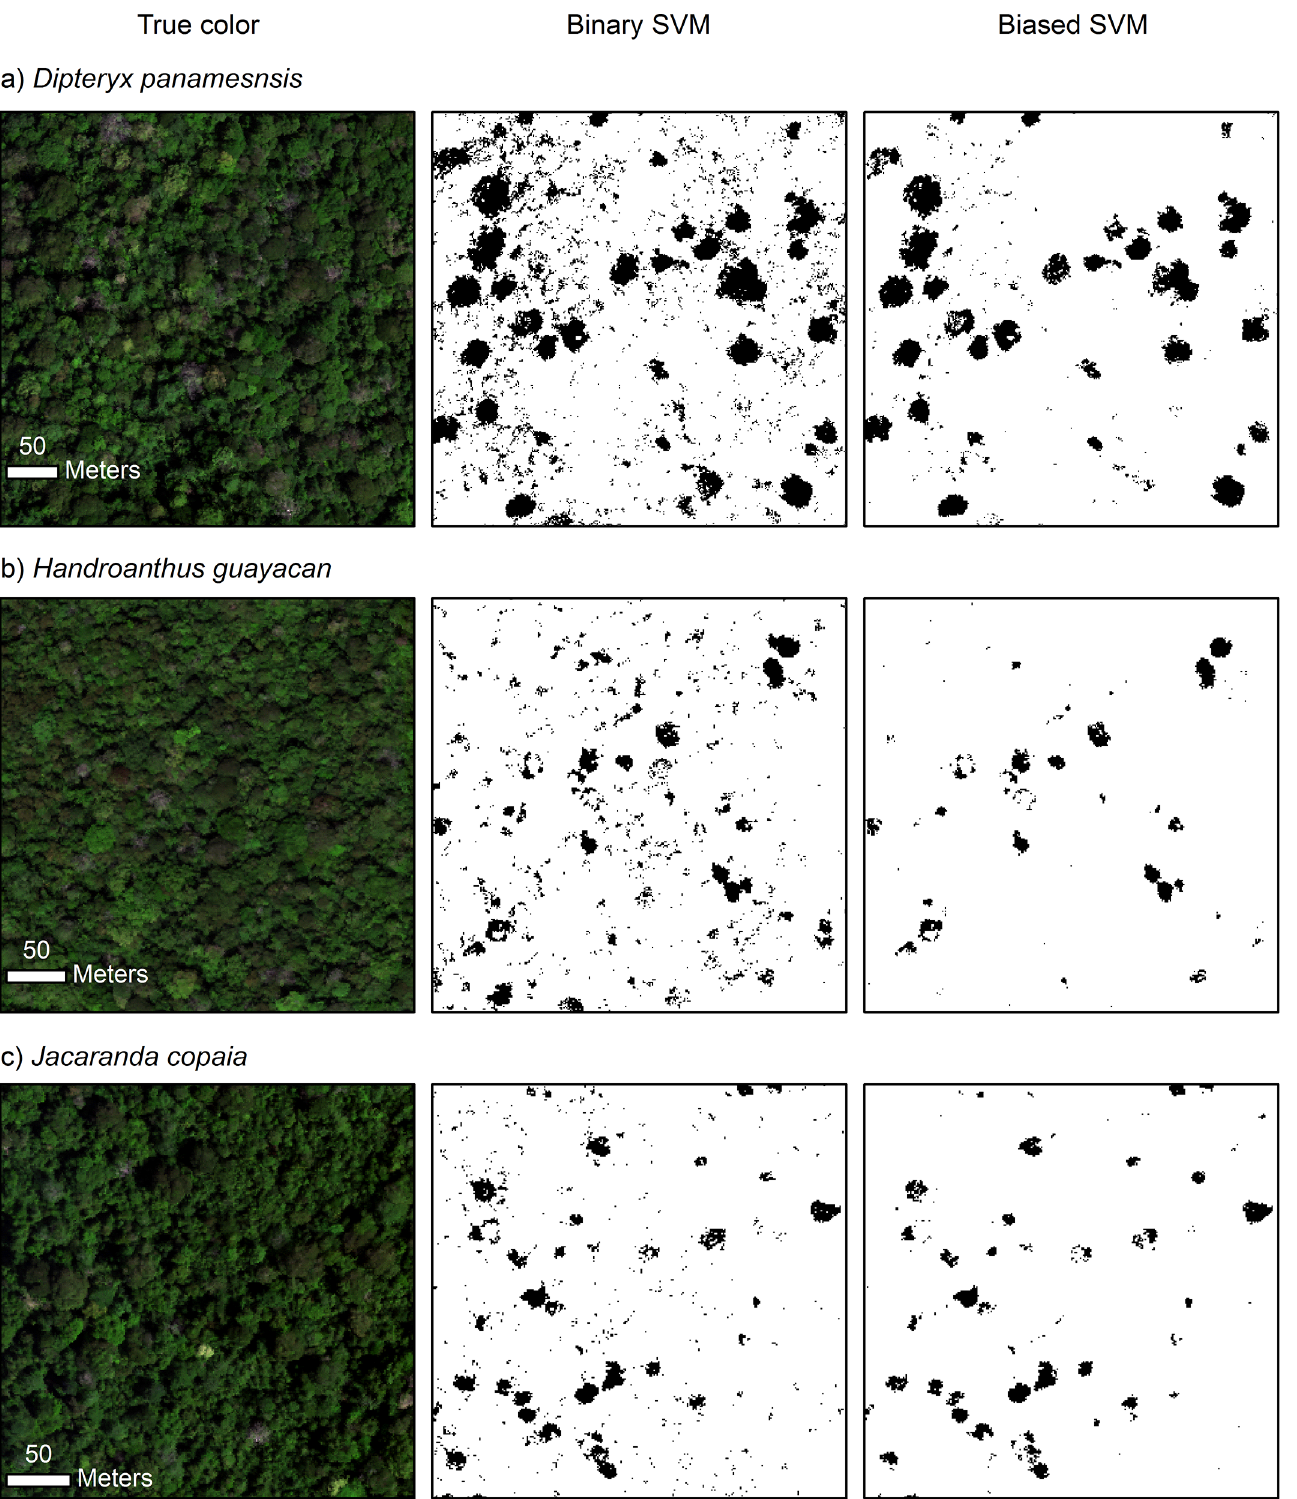
Fig 4. Mapped prediction results of binary and biased SVM models for the three focal species. The true-color representation of the raw imagery is on the left-hand side, results from the binary SVM models are in the center, and results from the biased SVM models are on the right-hand side. The three spectral bands used to display the true-color image are R = 640 nm, G = 550 nm, and B = 460 nm.